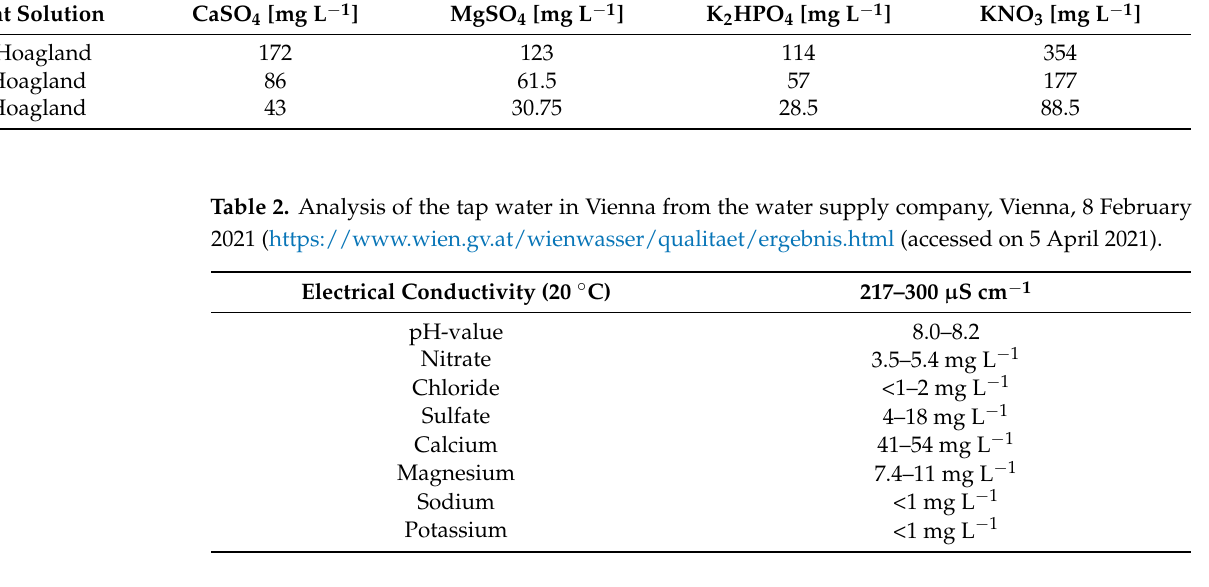
Table 1. Composition of the three Hoagland nutrient solutions applied during the study. Nutrient Solution